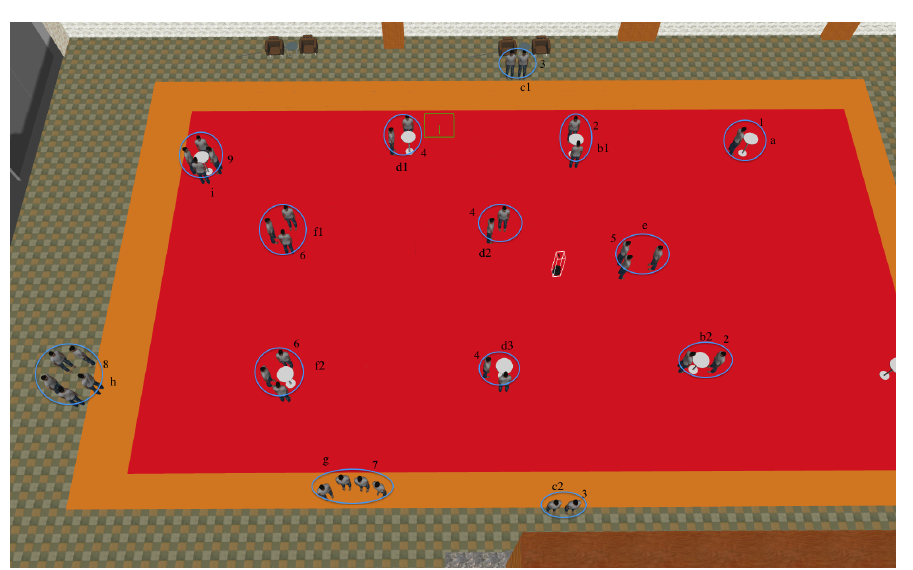
Figure 5. Simulation environment with VAs interacting in different formations and the robot navigating to join the groups. The numbers in the image represent formations as per the points listed in Section